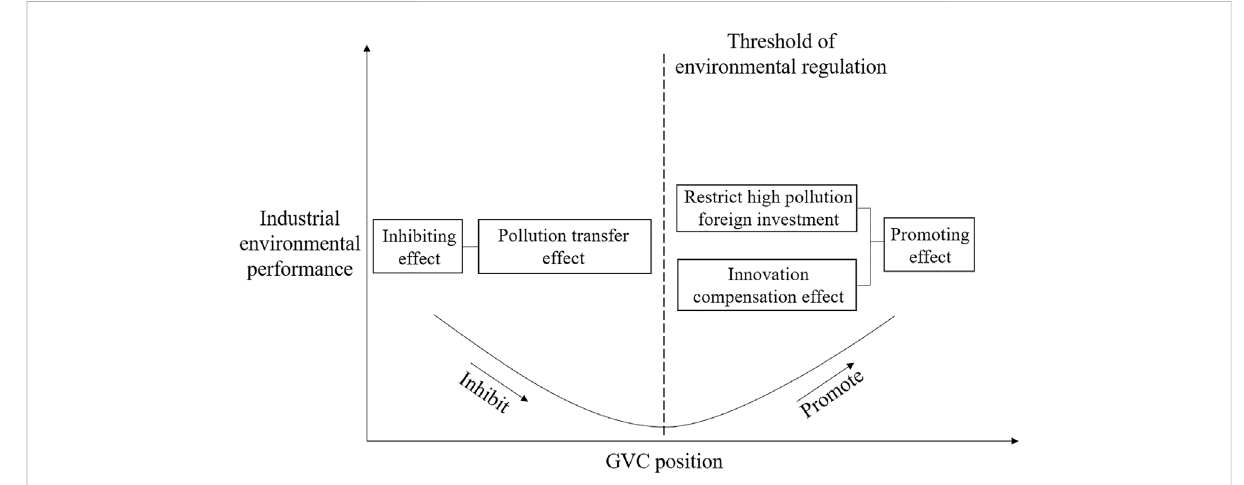
FIGURE 3 Impact mechanism of GVC embedding position on industrial environmental performance.